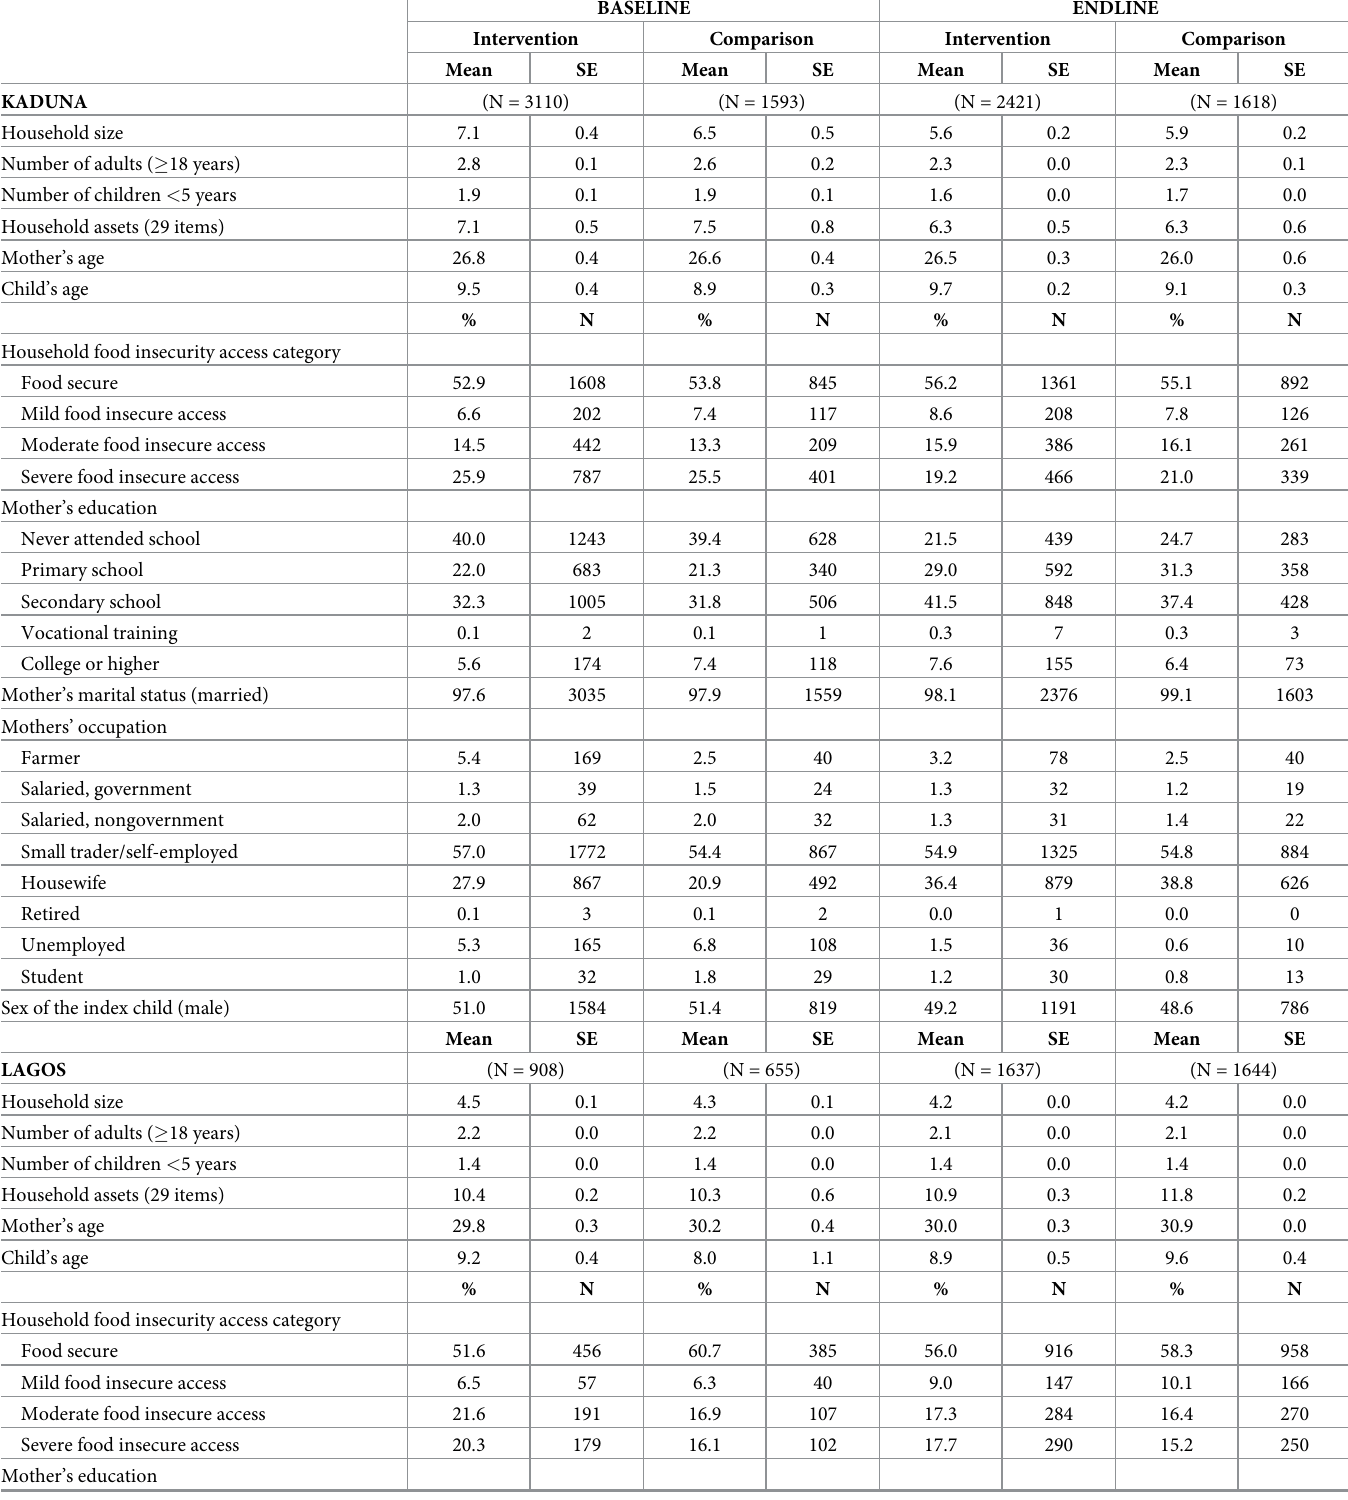
Table 1. Household and participant characteristics, by state 1